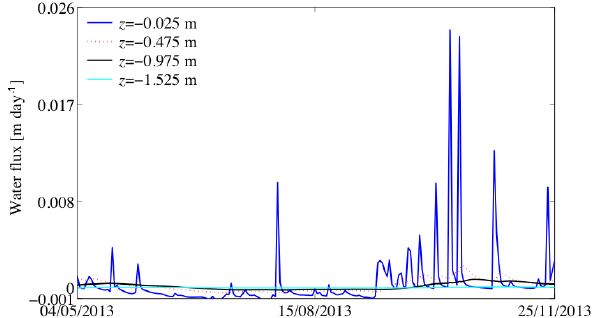
Figure 9. Temporal variation of the simulated water flux at depths z = 0.025, 0.475, 0.975 and 1.525m of the TT02 well. The positive and negative values indicate the downward and upward